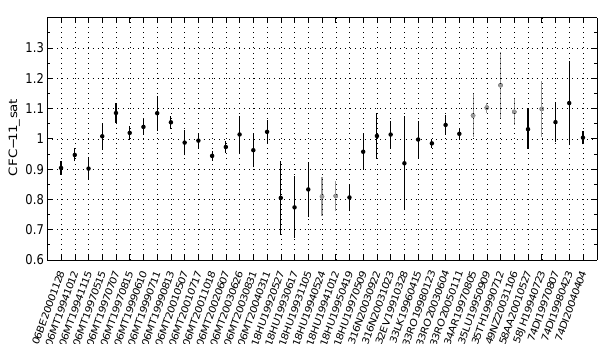
Figure 5 Figure 5. Mean surface saturation of CFC-11 for each cruise from the CARINA-ATL data set. Cruises were the CFC-11 data have been corrected or flagged as “poor” are highlighted in